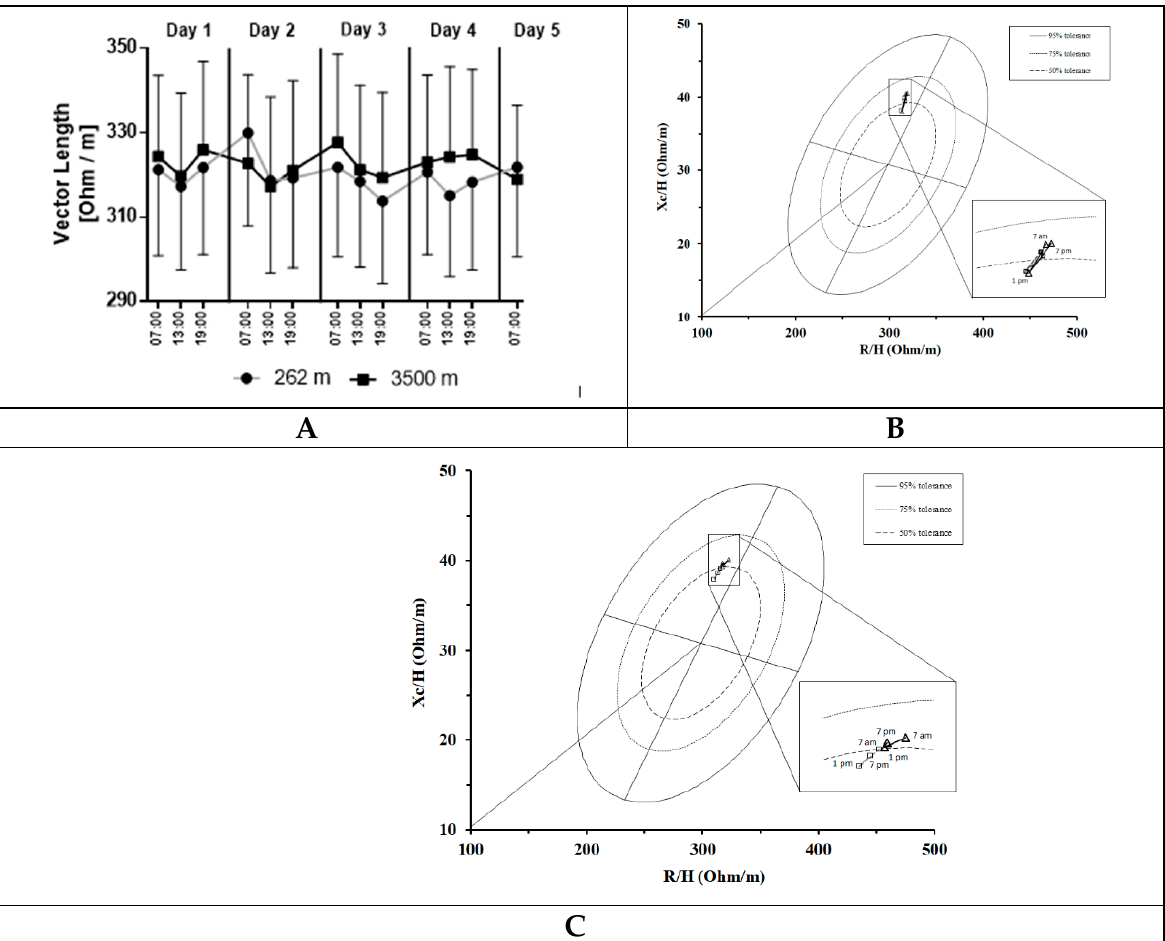
Figure 1. BIVA vector length over time. ( A ) Data represented as mean and standard error of mean (error bars) of nine subjects. ANOVA effects: time: p = 0.018, eta 2 = 0.149; interaction: p = 0.214, eta 2 = 0.083; condition: p = 0.920, eta 2 = 0.001. ( B ) Mean vector shifts during day 1, triangles: altitude, squares: sea level, plotted on the 50%, 75% and 95% tolerance ellipse of the general healthy Italian male population. ( C ) Mean vector shifts during day 4, triangles: altitude, squares: sea level, plotted on the 50%, 75% and 95% tolerance ellipse of the general healthy Italian male population. Each participant’s body weight showed a similar dynamic and no differences between conditions (Figure 2, ANOVA effects: time: <0.001, eta 2 = 0.265; interaction: p =